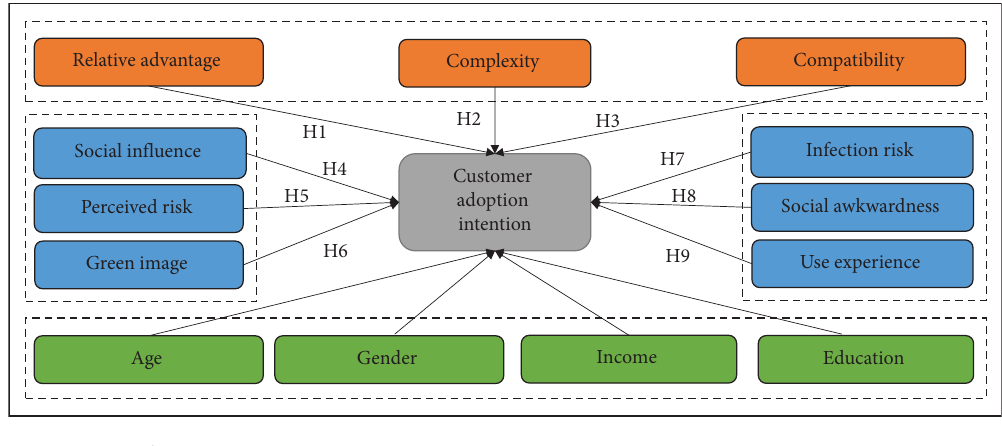
Figure 1: Customer adoption intention toward autonomous delivery vehicle model